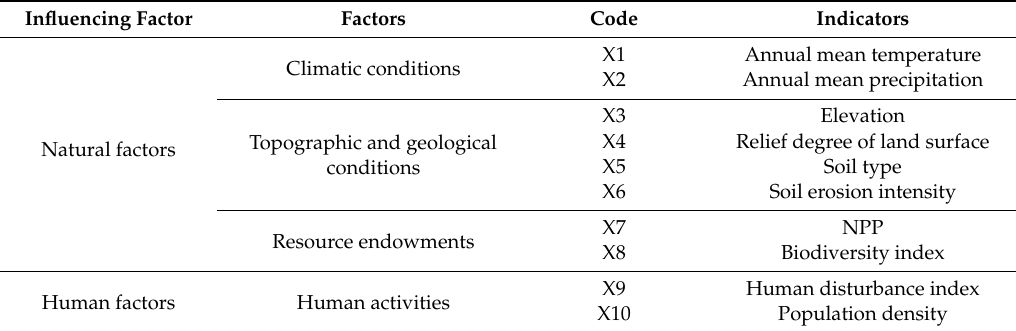
Table 4. Index system of influencing